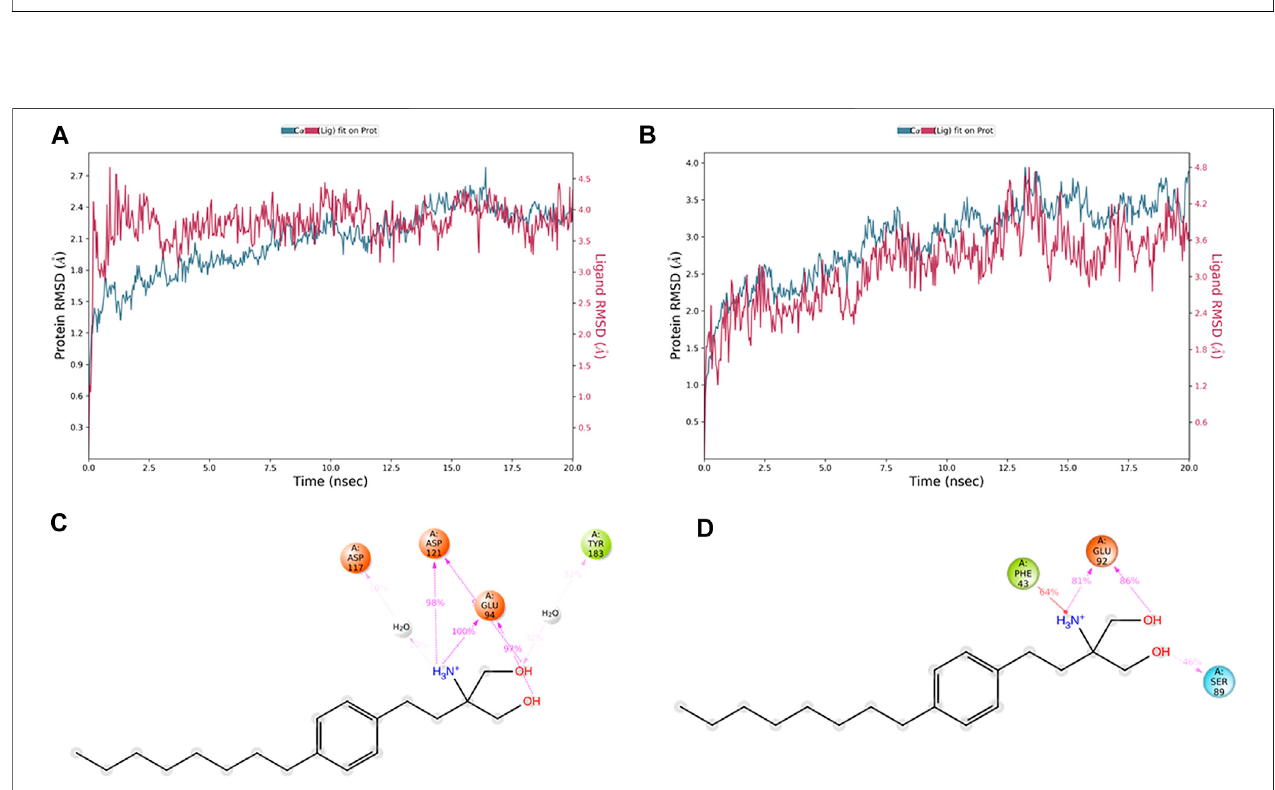
FIGURE 5 | VEGFA levels in retina of non-diabetic mice [panel (A) , CTR], diabetic mice [panel (A) , STZ], diabetic mice receiving fi ngolimod alone [panel (A) , STZ + Figolimod], or in combination with MC1R antagonist [panel (B) , STZ + Fingolimod + AGRP], MC5R antagonist [panel (B) , STZ + Fingolimod + PG20N], and SP1R1 antagonist [panel (B) , STZ + FTY720+Ex 26]. VEGFA levels, assayed by ELISA, are reported as pg/ml ± S.D. Statistical signi fi cance was assessed by one-way ANOVA, followed by Tukey ’ s multiple comparison test. * p < 0.05 vs CTR; † p < 0.05 vs STZ; ‡ p < 0.05 vs STZ + Fingolimod. N (cid:1) 10 retinas per group.